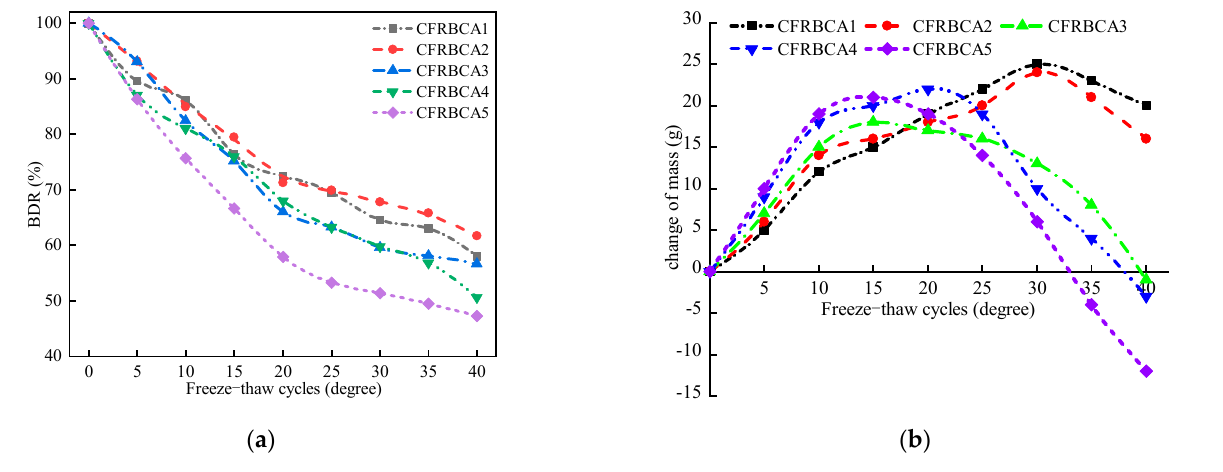
Figure 8. Relationship between freeze-thaw cycle with BDR and mass loss: ( a ) Freezing resistance coefficient of specimens for different freeze-thaw cycles, ( b ) Relationship between specimen mass and freeze-thaw cycle.